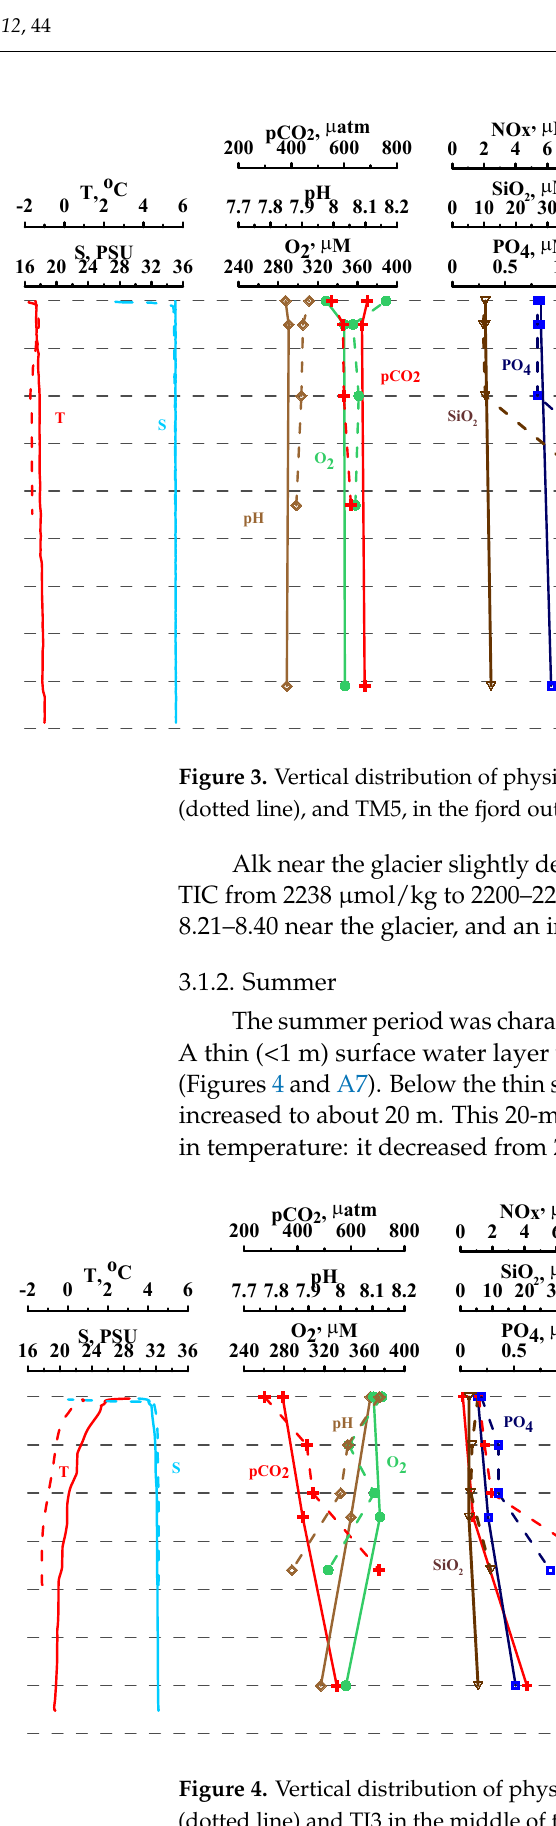
6 of 30 Figure 2. Vertical distribution of the temperature, T, salinity, S, pH, pH, dissolved oxygen, O 2 , phos- phate, PO 4 , nitrate, NO x , silicate, SiO 2 , dissolved organic carbon, DOC, total alkalinity, Alk, total inorganic carbon, TIC, carbonate, CO 3 , partial pressure of CO 2 , pCO 2 , and aragonite saturation (Arag. Sat.) at the station near the glacier T1 (dotted line) near the outlet T7 (solid line), sampled on 19/02/2011.